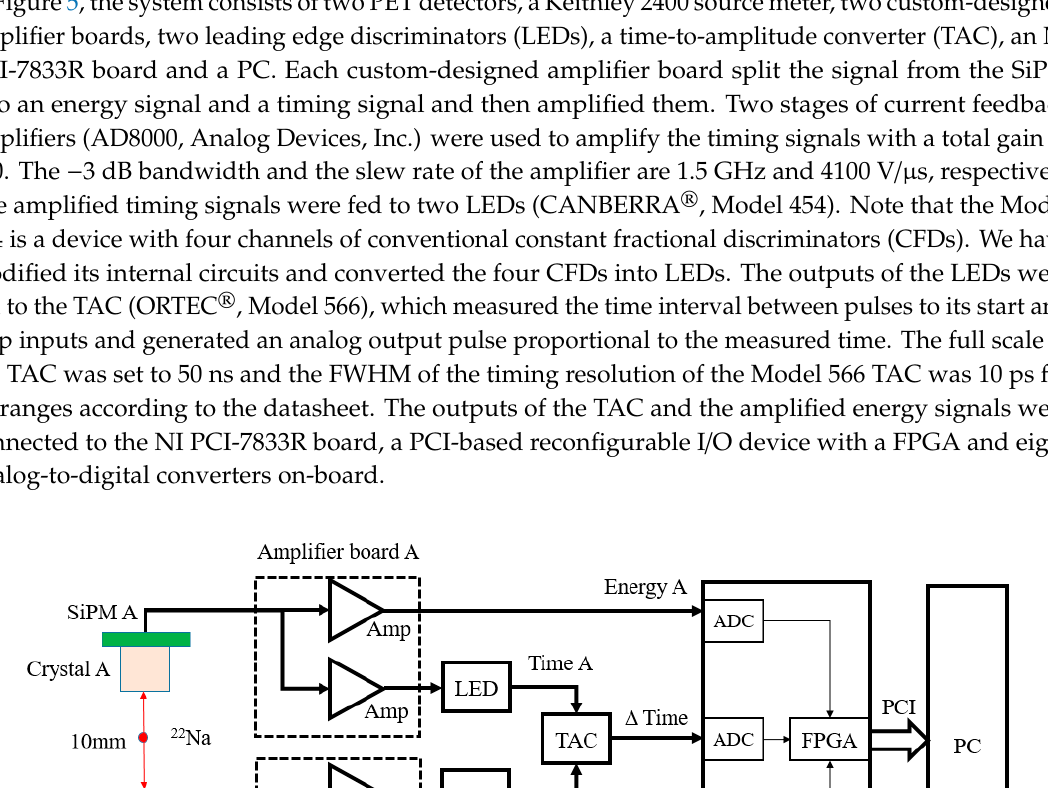
Table 4. Parameters of the LYSO taken from di ff erent positions of the crystal boule.